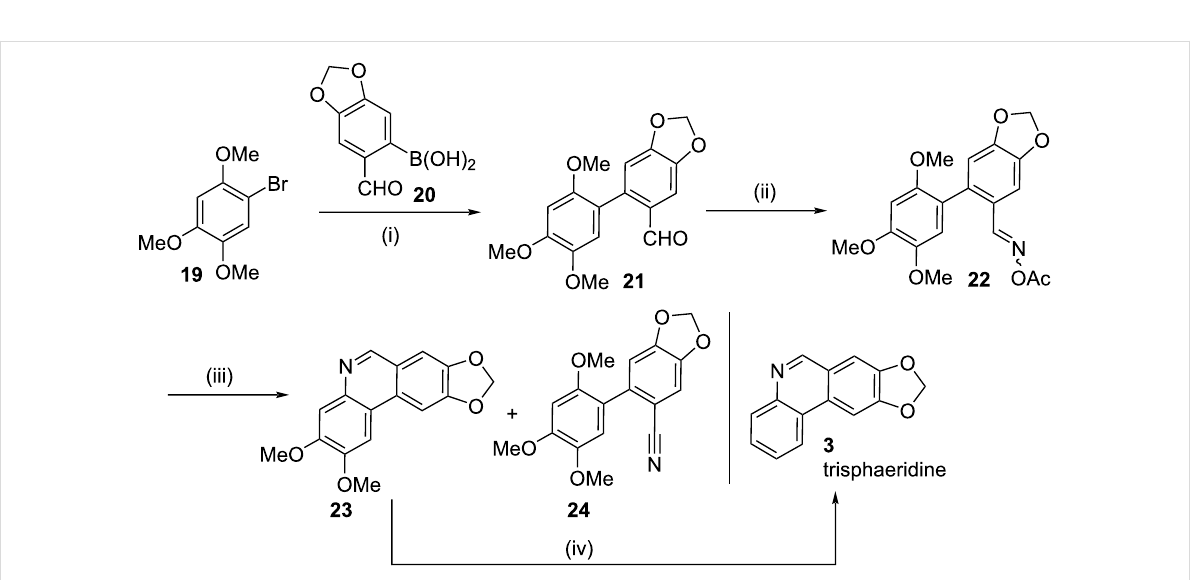
Scheme 5: Synthesis of trisphaeridine . Reagents and conditions (i) cat. Pd(PPh 3 ) 4 , aq Na 2 CO 3 , DME, reflux, Ar, overnight, 58%; (ii) (a) NH 2 OH·HCl, NaOAc, EtOH/H 2 O (1:1), 35 °C, 30 min, (b) AcCl, pyr, rt, 3 h, 74% (for the two steps); (iii) UV irradiation, (450 W medium pressure Hg lamp), t -BuOH, rt, 1 h, 23 41% and 24 53%; (iv) (a) CAN, MeCN/H 2 O (2:1), 0 °C, 30 min, (b) Zn, NaCl, AcOH, 150, 3 h, 37% (overall for the two